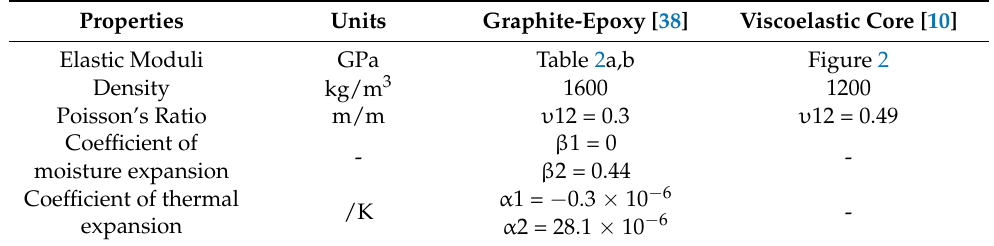
Table 1. Material Properties [10,38] (Adapted with permission from Elsevier B.V., License Number: